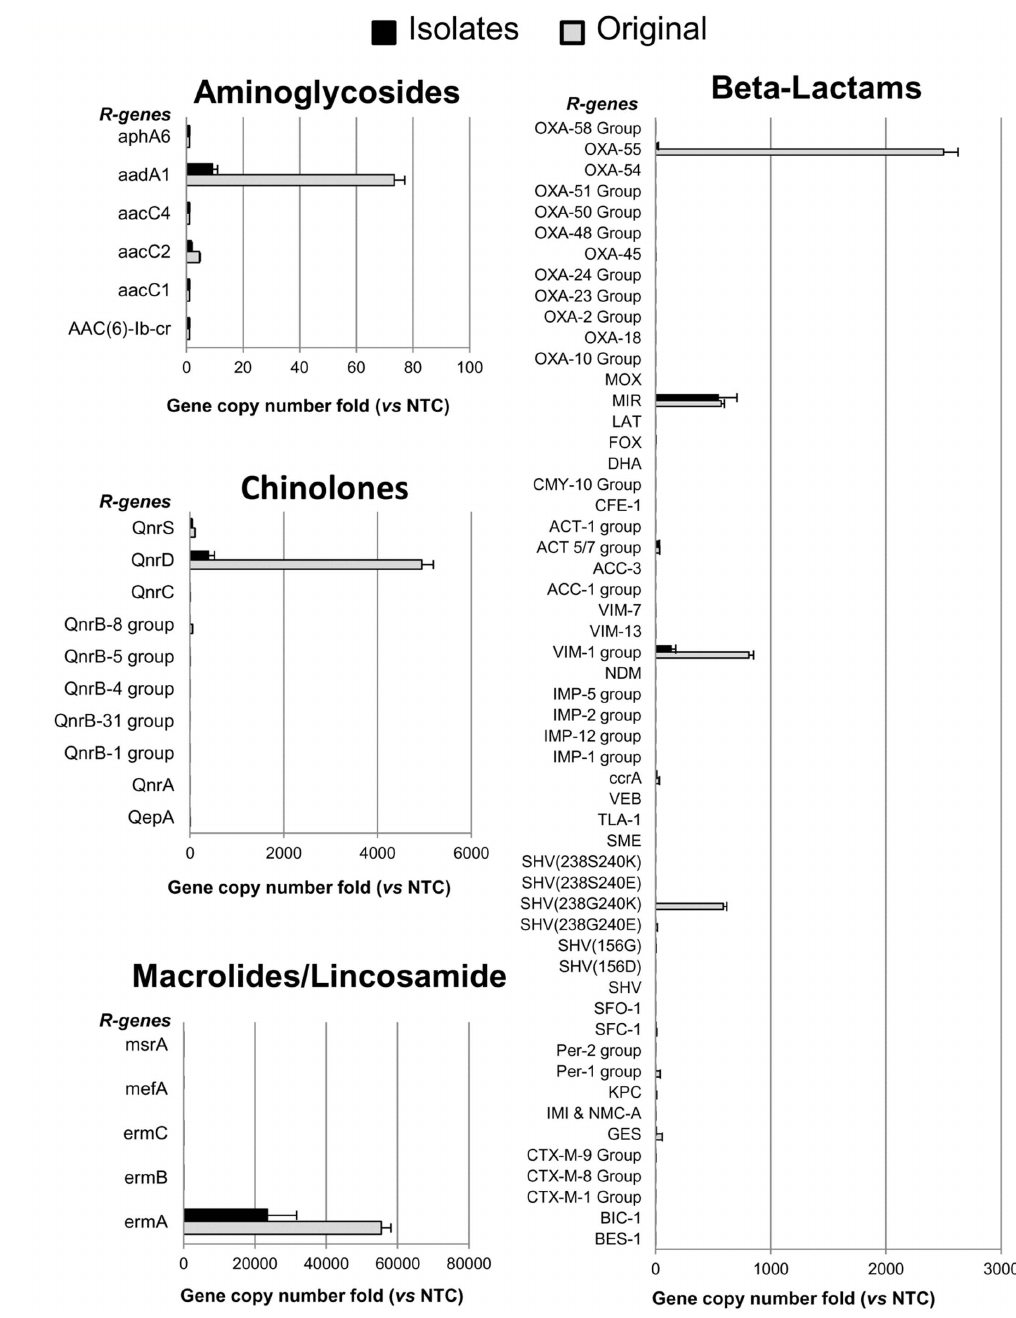
Figure 6. Antimicrobial resistance genes profile by qPCR assay. The DNA of the Bacillus spp. from the cleaning products (Original) and from 20 Bacillus spp. colonies isolated from the treated surfaces up to 12 months after the beginning of the cleaning protocol (Isolates), was analyzed by qPCR Microarray to detect the presence of antibiotic resistance genes (R genes). DNA from E. coli JM101 strain was used as negative control (NTC). Results are reported as folds of gene copy number comparing the detected values with those obtained in the negative control DNA, both normalized for bacterial cell number. Those genes coding for antibiotics that are not included in the figure (i.e. vancomycin, tetracyclins) were negative both in Original and Isolates collections. Results are reported as mean 6 standard